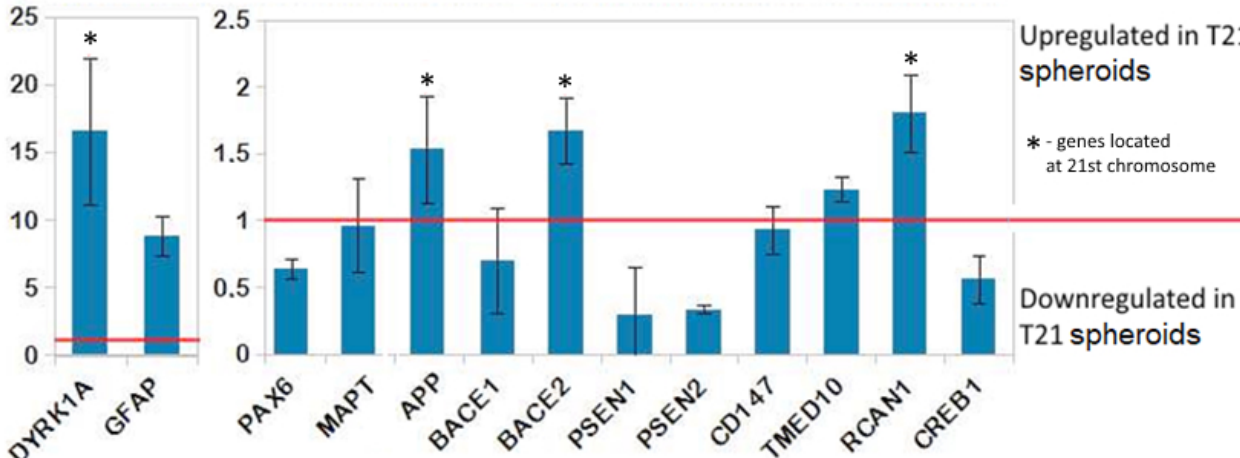
Figure 5. Expression level ratio between TS21 and NK spheroids. The red line marks equal expression in the TS21 and normal karyotype spheroids. Ratio values greater than 1 indicate upregulated genes in the TS21 spheroids. Ratio values less than 1 indicate downregulated genes in the TS21 spheroids respective to the normal karyotype. Asterisks (*) label genes carried on chromosome 21. The normalization factors for qRT-PCR analysis were calculated based on REEP5, C1orf43, and HMBS.